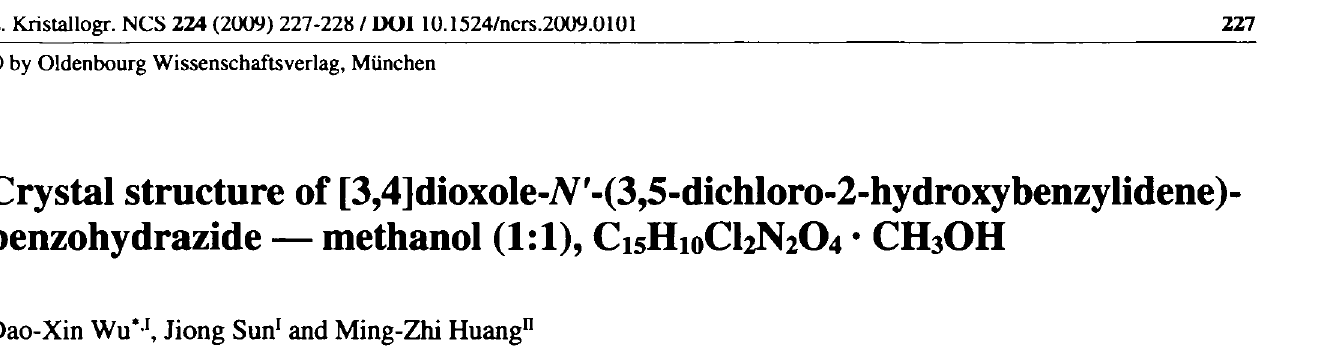
Table 1. Data collection and handling. Crystal: